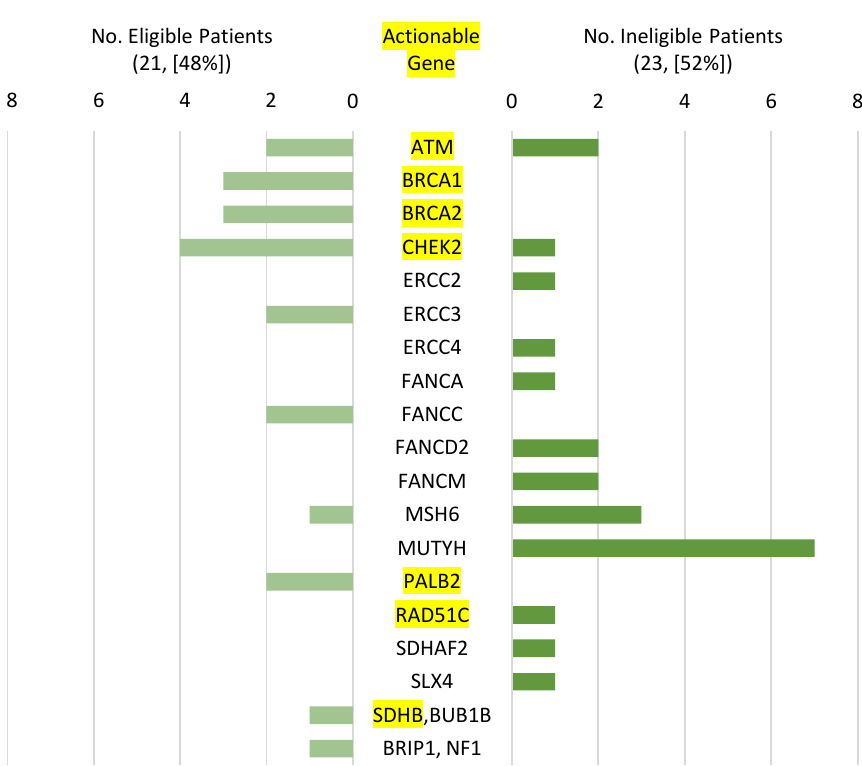
Figure 2. Number of patients with PGVs eligible to receive clinical genetic testing according to NCCN, ACMG, and NSGC guidelines for cancer type. Data represent 46 variants from 44 patients. Two patients harbored more than one variant and are listed at the bottom of the figure. Yellow highlighting indicates clinically significant